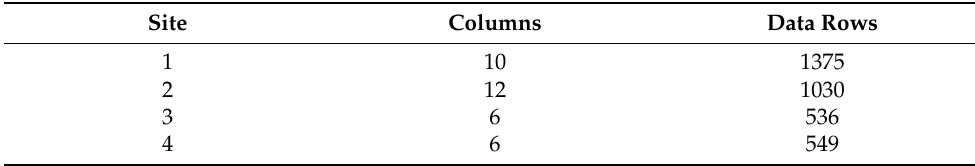
Table 5. Data at a distance ≤ 2 m from its associated penetrometer.